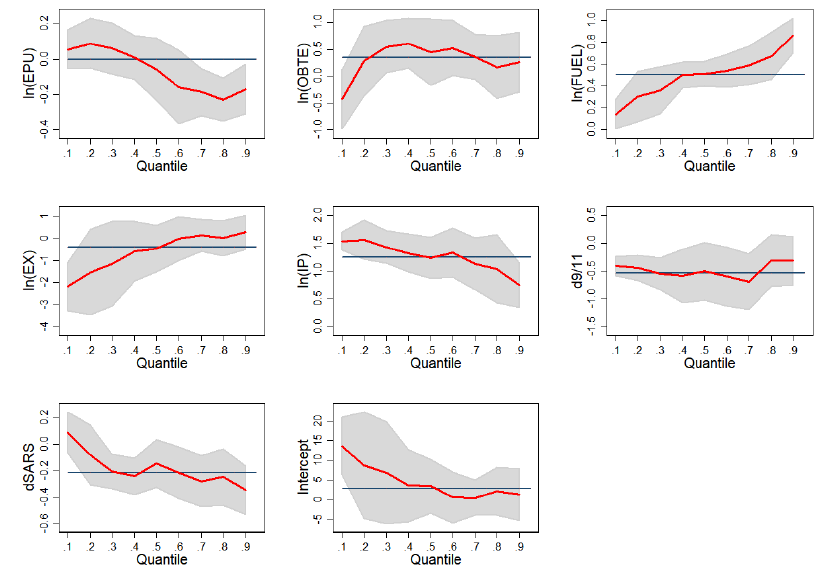
Figure 6. Model 3: Plot of the QR coefficient of the